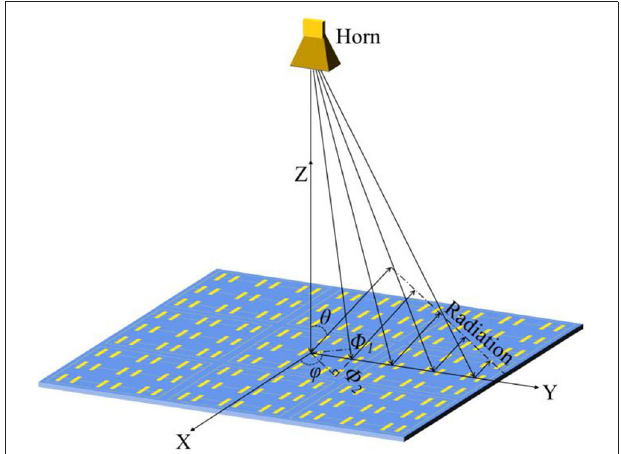
FIGURE 5 | Schematic of the reflectarray.